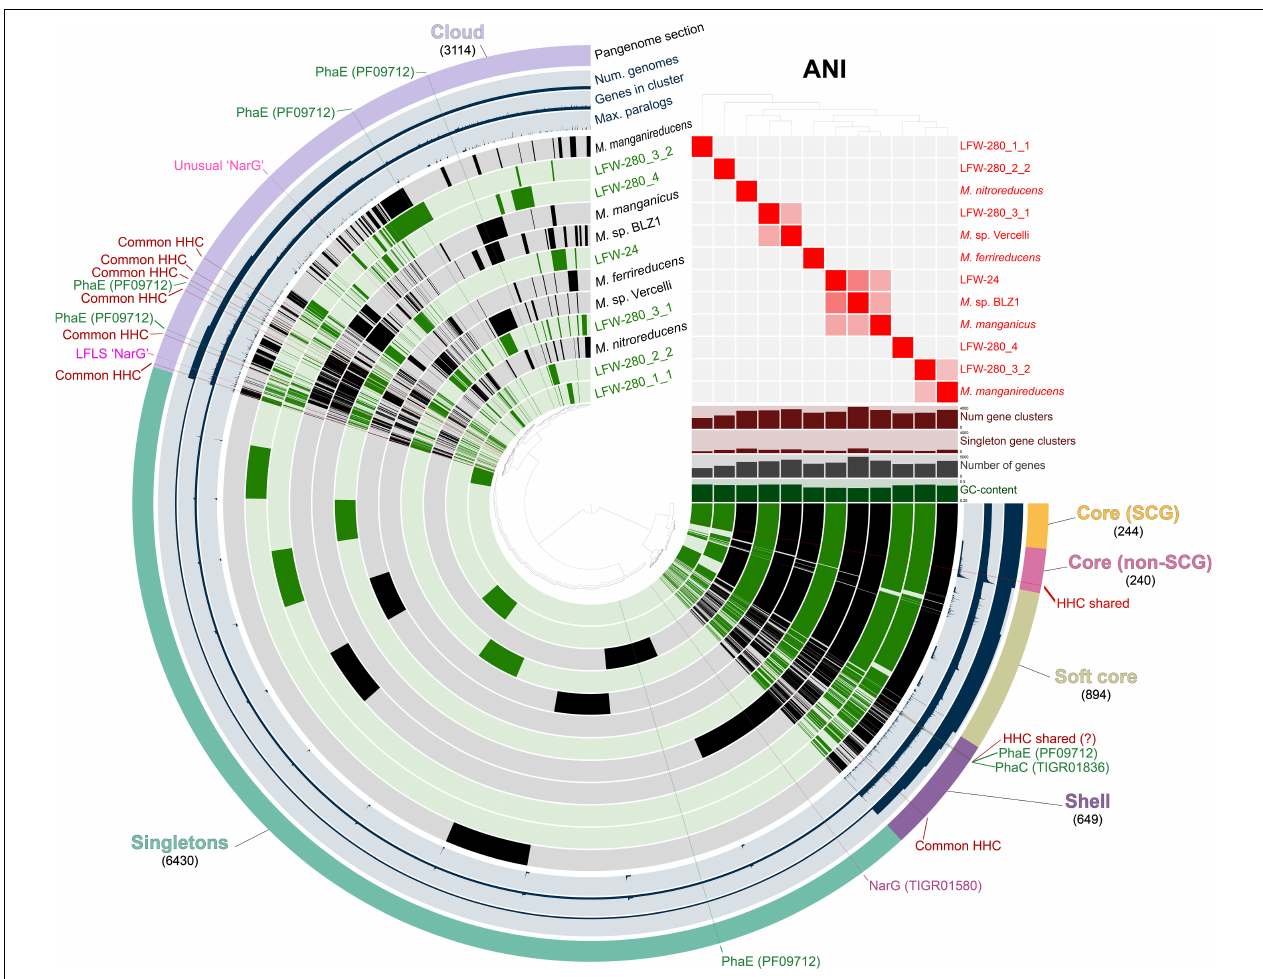
FIGURE 6 | Pangenomic analysis of genus ‘ Candidatus Methanoperedens.’ Pangenome was generated with 6 ‘ Ca. Methanoperedens spp.’ MAGs from LFLS (green) and 6 reference genomes (black), accounting for a total of 39,271 protein-coding genes grouped in 11,571 gene clusters. Gene clusters generated with an MCL inflation value of 6.0. ‘Common HHC’ indicates high-heme cytochrome gene clusters present in at least 4 different MAGs. MAGs are ordered based on the presence-absence of gene clusters. ANI heatmap show values between 85 and 100%.